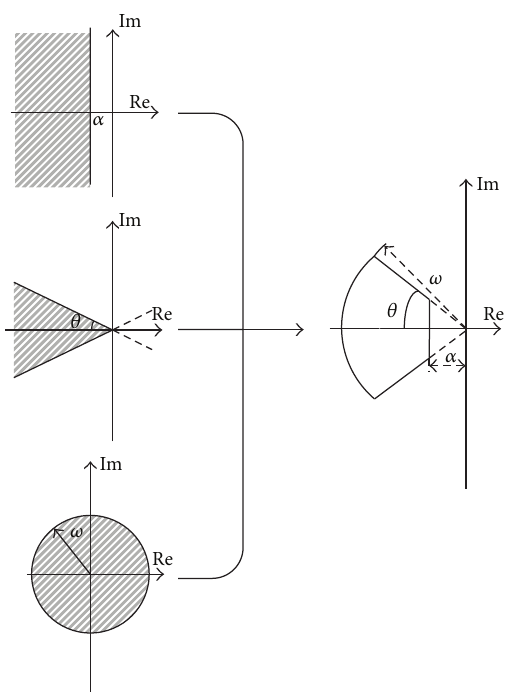
Figure 1: Construction sector in terms of classic stability